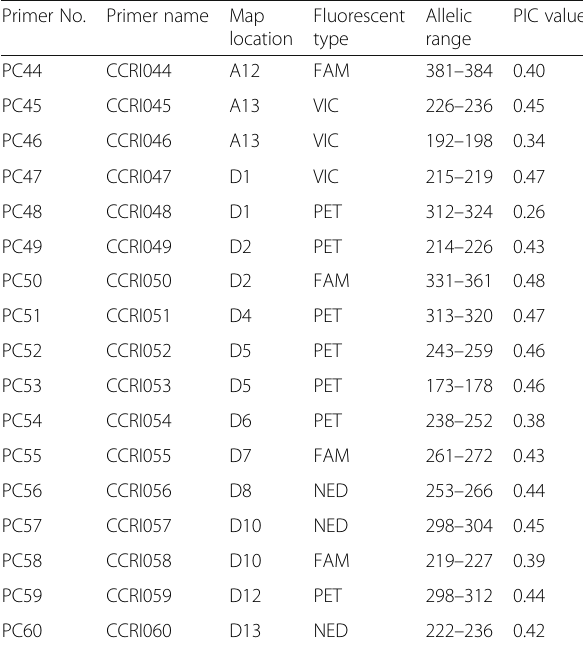
Table 2 Information on 60 perfect SSR primers (Continued)